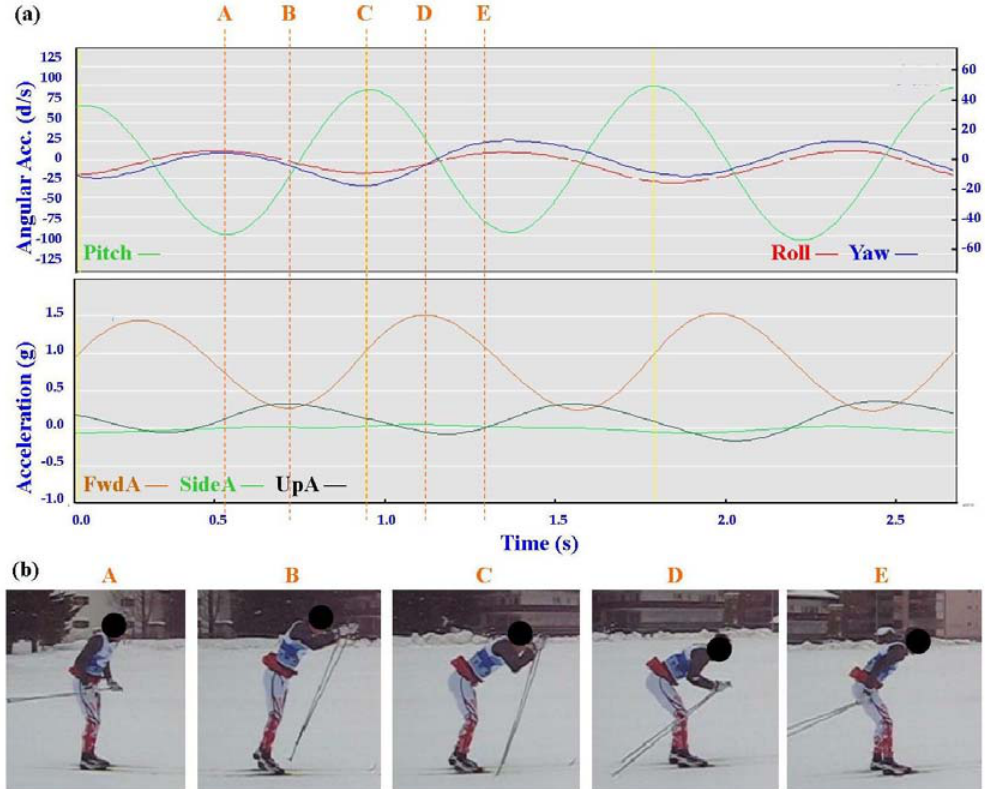
Figure 3. ( a ) Screenshot of Double Poling (DP) gyroscope and accelerometer traces against time; ( b ) DP body position for selection